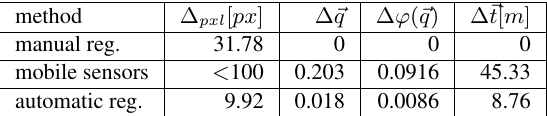
when lighting conditions were significantly different to the tex- tured model input images. Moreover, due to rainfall in preceding days, the mudstone beds in the outcrop are significantly darker in colour. Keypoint matching and pose retrieval failed with the op- timised parameter set of sec. 6.2, as shown in fig. 9(a). We apply a gamma adaptation as a post-processing shader to the synthetic image because of the stronger reflectance of the rock. This im- proves the keypoint matching, though pose extraction still